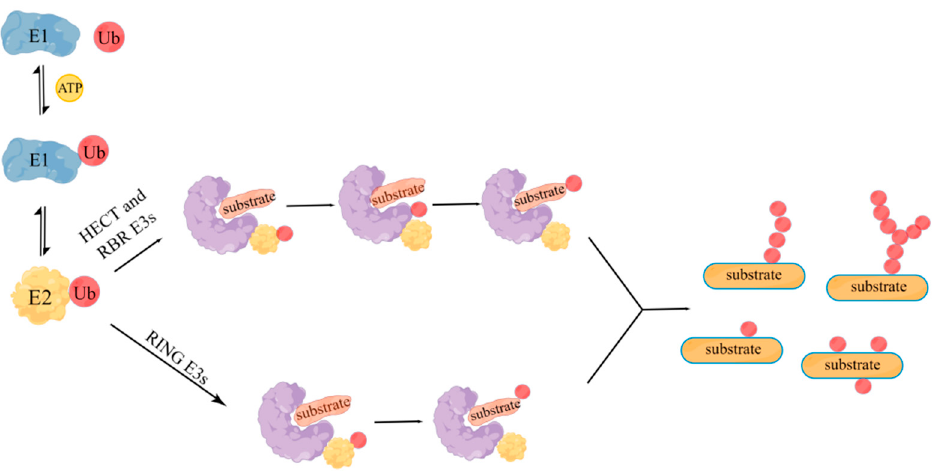
Figure 1. Ubiquitination mediated by three ubiquitin ligase families. Ubiquitination modification involves a series of reactions of ubiquitin-activating enzyme E1, ubiquitin-binding enzyme E2, and ubiquitin ligase E3: firstly, when ATP is supplied, E1 enzyme adheres to the tail of ubiquitin molecule, and then E1 enzyme transfers the activated ubiquitin molecule to E2 enzyme. Then, E2 enzyme and some different E3 enzymes jointly recognize the target protein and modify it. The E3 enzyme is shaped like a clip, and the target protein is connected in the middle gap. The left domain of the enzyme determines the specific recognition of the target protein, and the right domain locates the E2 enzyme to transfer ubiquitin molecules. According to the ubiquitin transfer mechanism of E3 enzymes, E3 enzymes are divided into RING, HECT, and RBR families. HECT and RBR E3s contain a catalytic cysteine that receives ubiquitin from E2 ubiquitin complex, and then transfer the ubiquitin to substrate; while RING E3s can directly catalyze the transfer of ubiquitin from E2 ubiquitin complex to substrate.